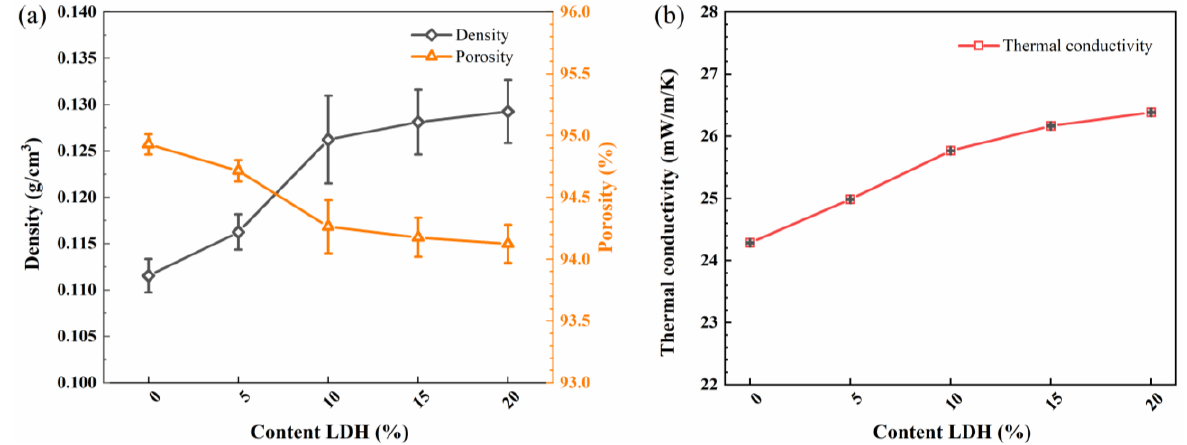
Figure 6. Density and porosity ( a ) and thermal conductivity ( b ) of SA and LDH/SA